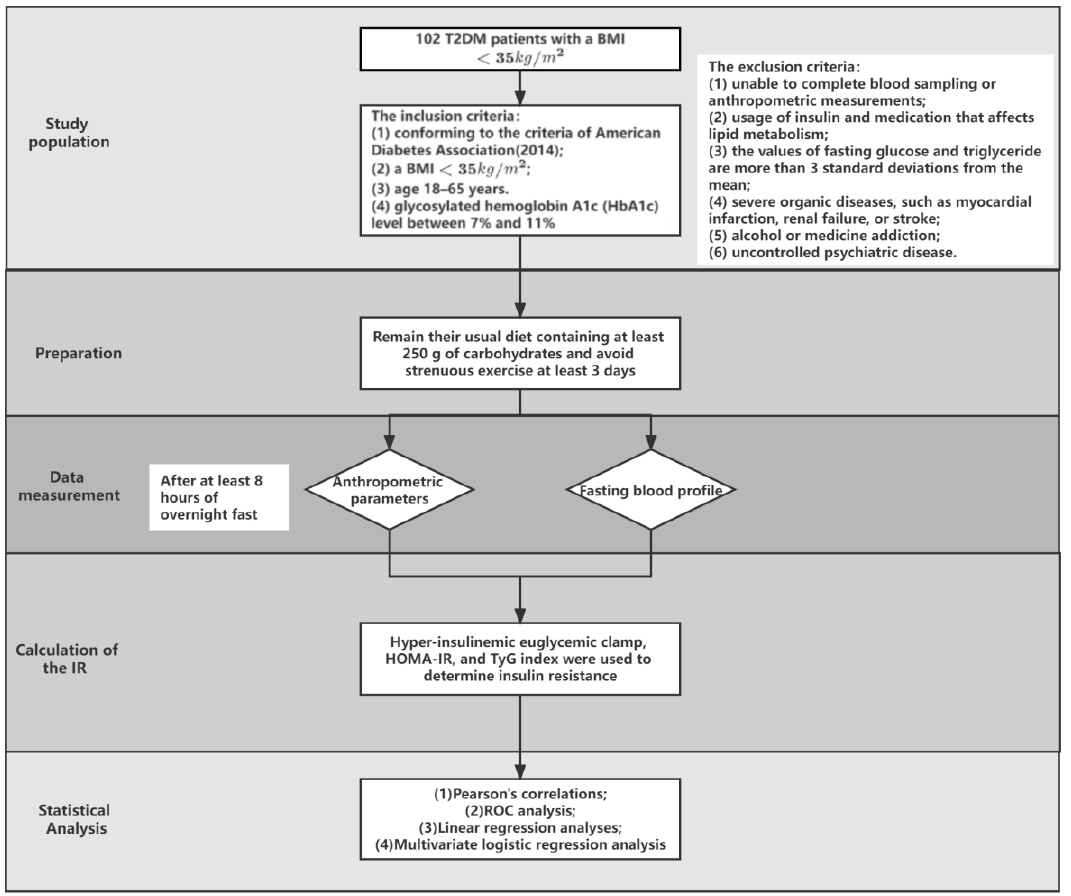
Figure 1. Schematic of the research methods.